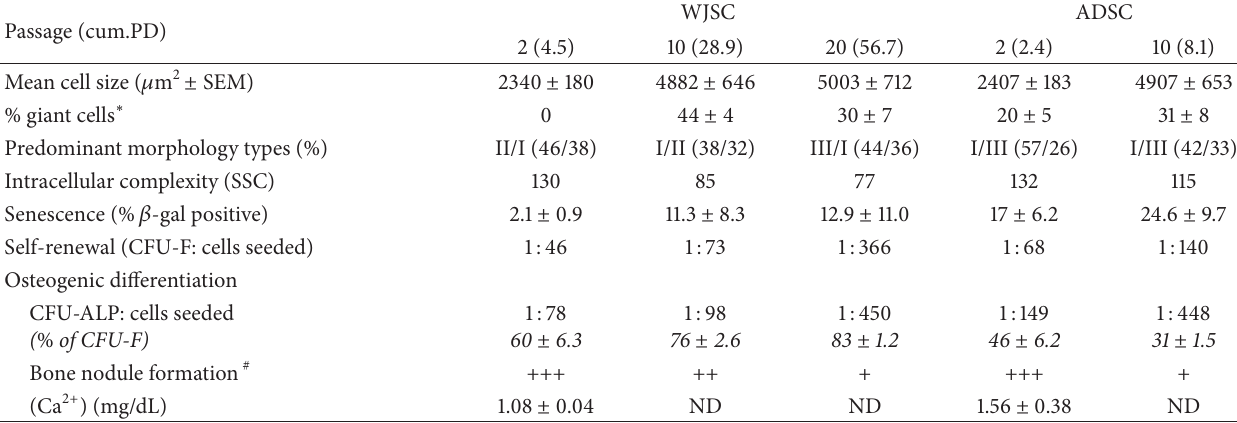
Table 3: Overview of phenotypic characteristics of ADSC and WJSC at early (p.2) and late (p.10 and p.10/20, resp.) passages. Passage